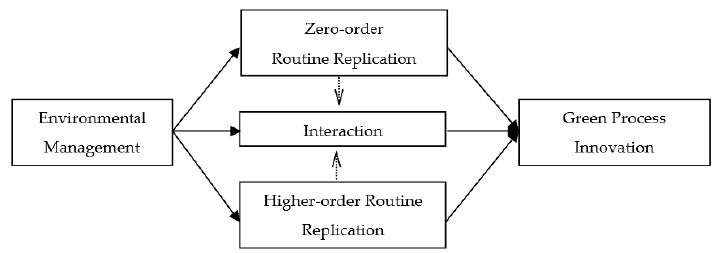
Figure 1. Theoretical framework.